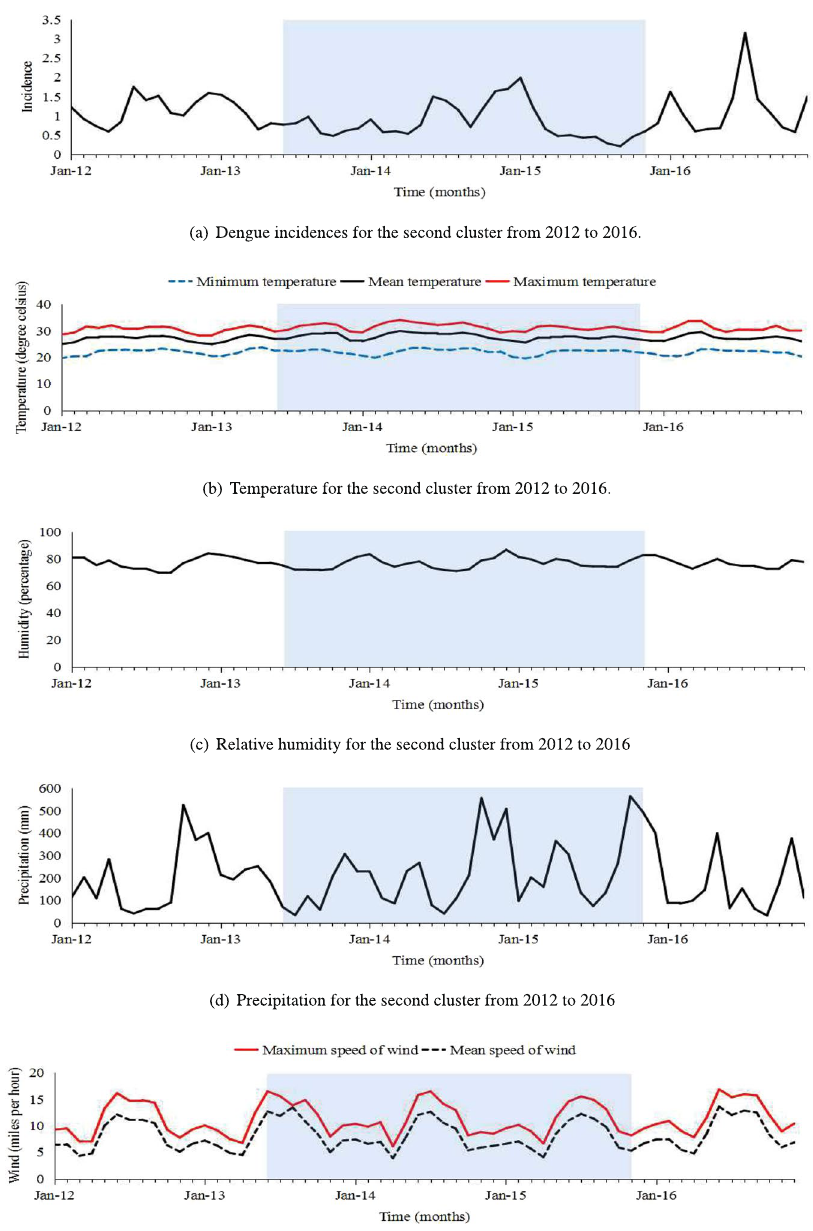
Figure 3. Dengue incidences and monthly climatic factors between 2012 and 2016 for the second cluster. The clustering period is highlighted in blue from June 2013 to November